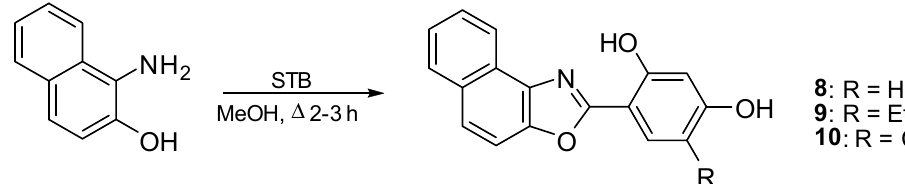
Figure 3. Synthesis scheme of naphtho[1,2- d ][1,3]oxazoles ( 8 – 10 ).